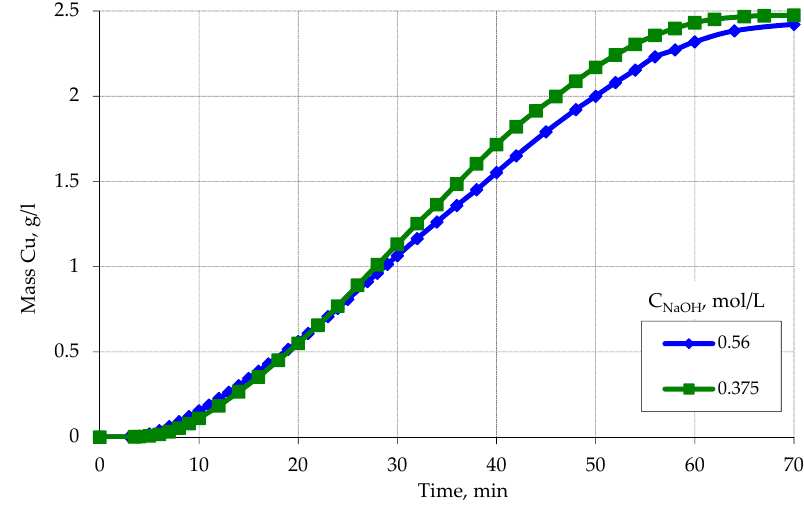
Figure 16. Kinetic curves of copper ion reduction on the activated surface of polypropylene waste.